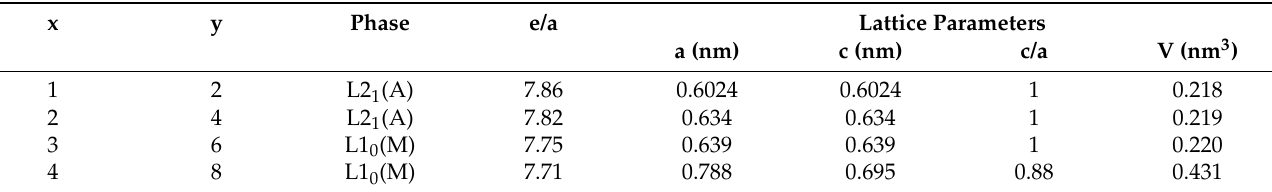
Table 2. Structural parameters estimated for XRD pattern of the alloys.